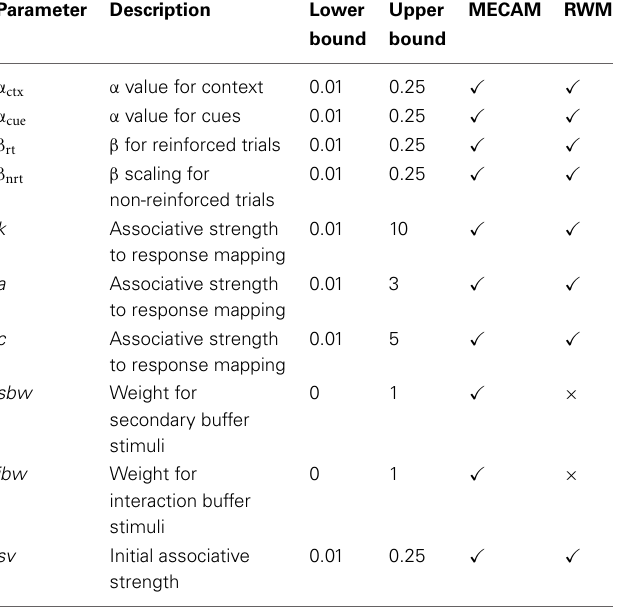
Table A2 | State of buffers on three successive trials; AB + , ABC − , and BC − .